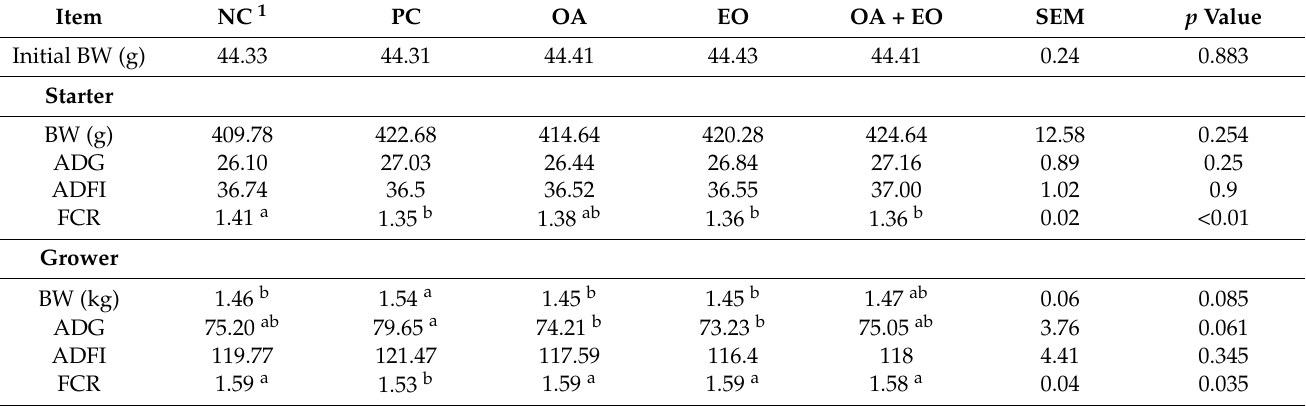
Table 2. Effects of individual or combination of organic acids and essential oils on growth